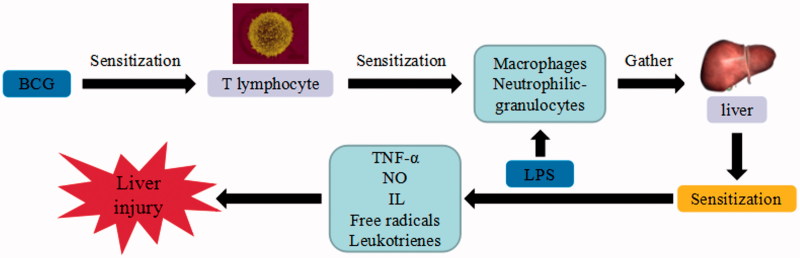
BCG/LPS-induced liver injury. BCG/LPS trigger the continuous development of hepatocyte injury by inducing cell stress via inflammation and sensitization, resulting in hepatic necrosis and liver injury. TNF-α: tumor necrosis factor α; IL: interleukin.